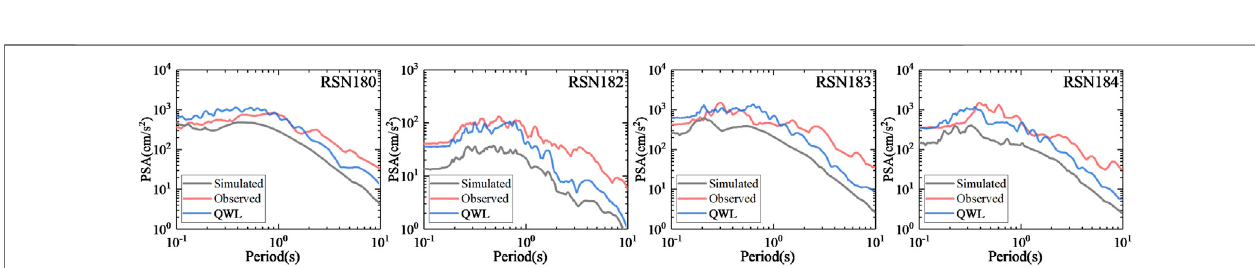
Frontiers in Earth Science |